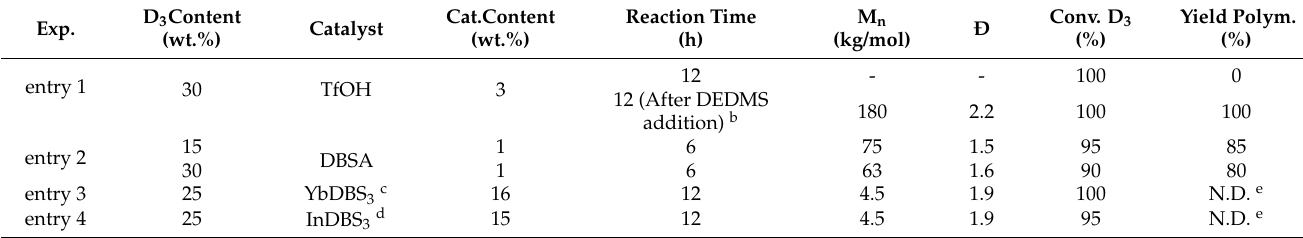
Molecules 2021 , 26 , x FOR PEER REVIEW